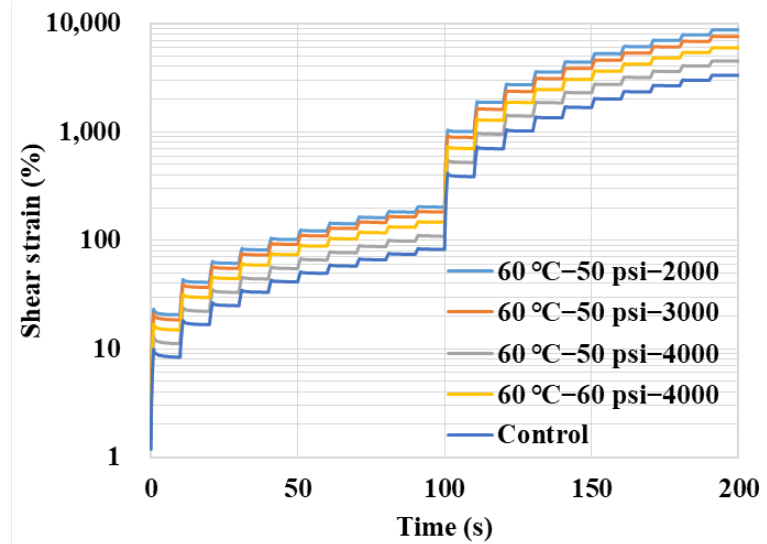
Figure 7. Shear strain curves in MSCR tests.